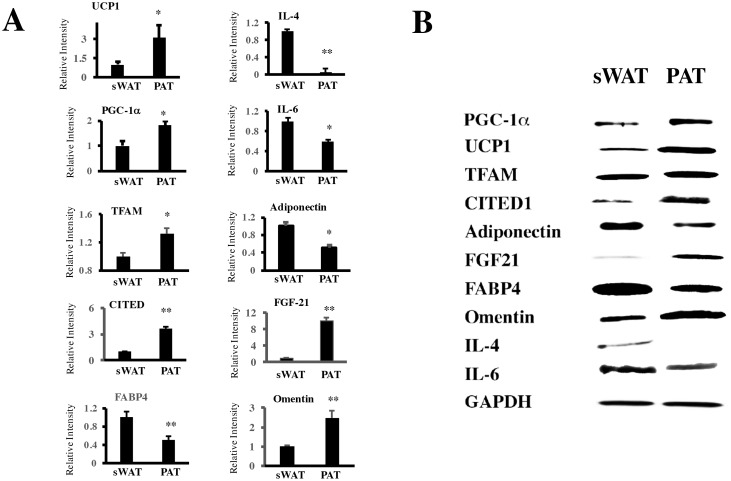
Protein expression of in subcutaneous adipose tissue (sWAT) and periaortic adipose tissue (PAT).(A) Western Blot was performed in patients with BMI normal (18–24.9) to compare the expression of different proteins. UCP-1, Uncoupling protein 1; PGC-1a PPARg coactivator 1 alpha; FABP4, fatty acid binding protein 4; IL-4, Interleukin 4; IL-6, Interleukin 6; TFAM, transcriptor factor A, mitochondrial precursor; CITED1, CBP/p300 interactive transactivator 1; FGF21, fibroblast growth factor 21. * p<0.05 and ** p< 0,01 mean ± standard deviation (SD) of relative density of antibodies between of sWAT and PAT. In (B), a representative image of Western blot.